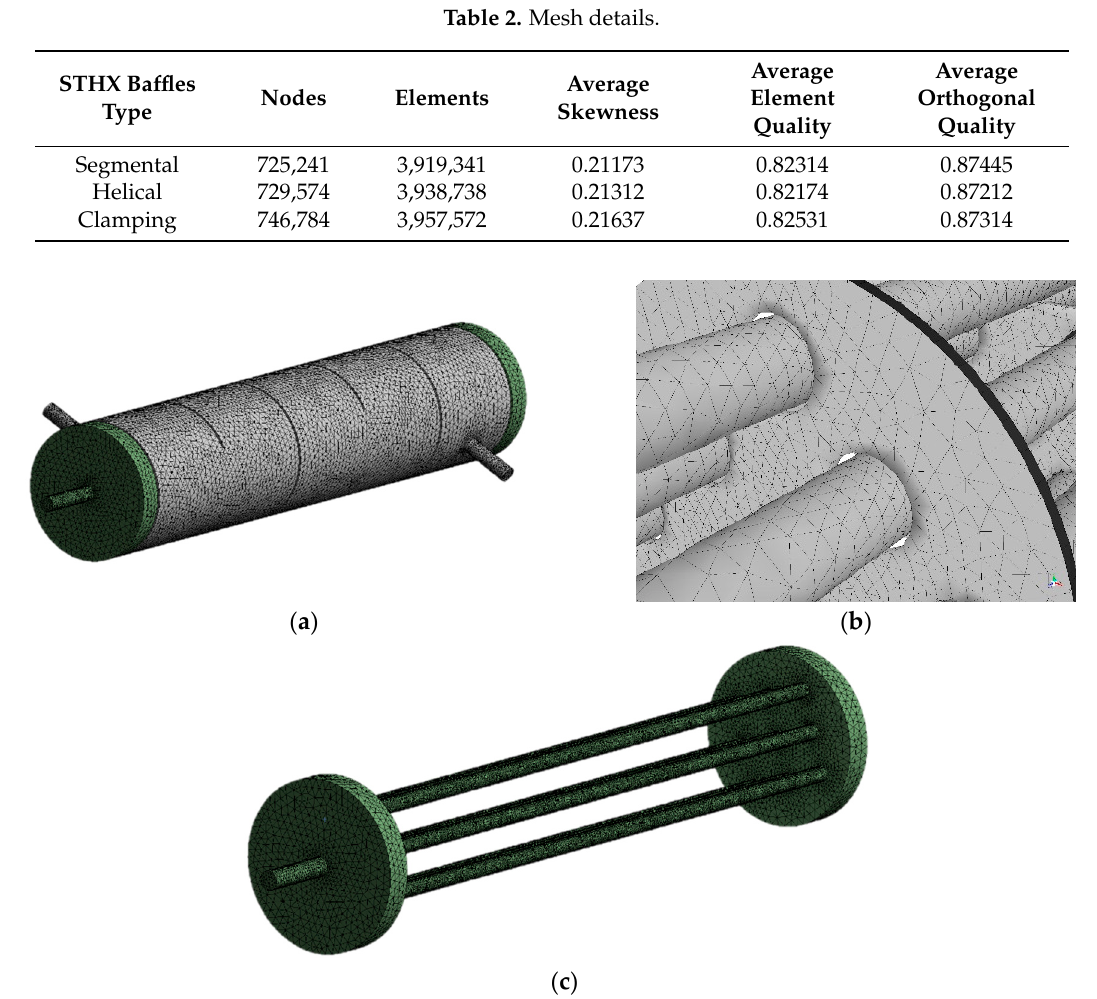
Figure 3. Mesh: ( a ) complete geometry; ( b ) baffle and tube; and ( c ) tubes.